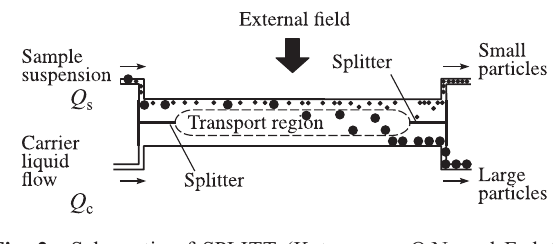
Fig. 2 Schematic of SPLITT (Katasonova O.N. and Fedotov P.S.,